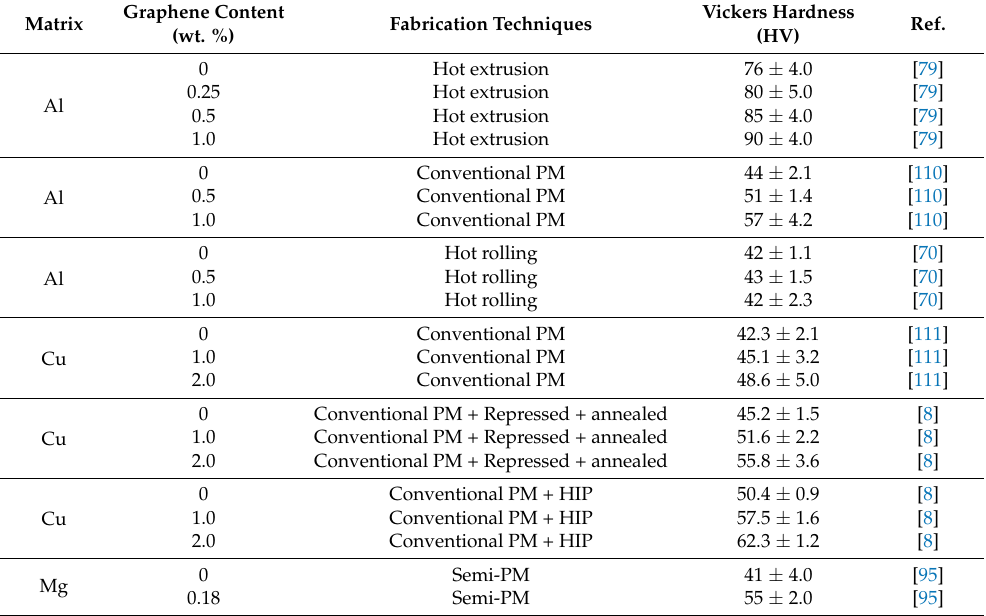
Table 5. Vickers hardness of different metals and their metal matrix nanocomposites reinforced with